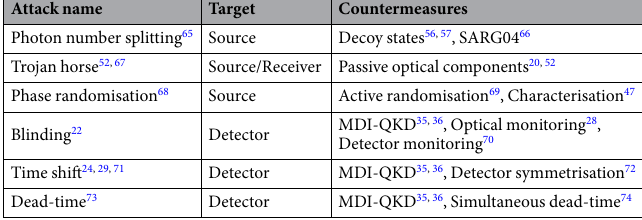
Table 1. Examples of side channel attacks on one way BB84